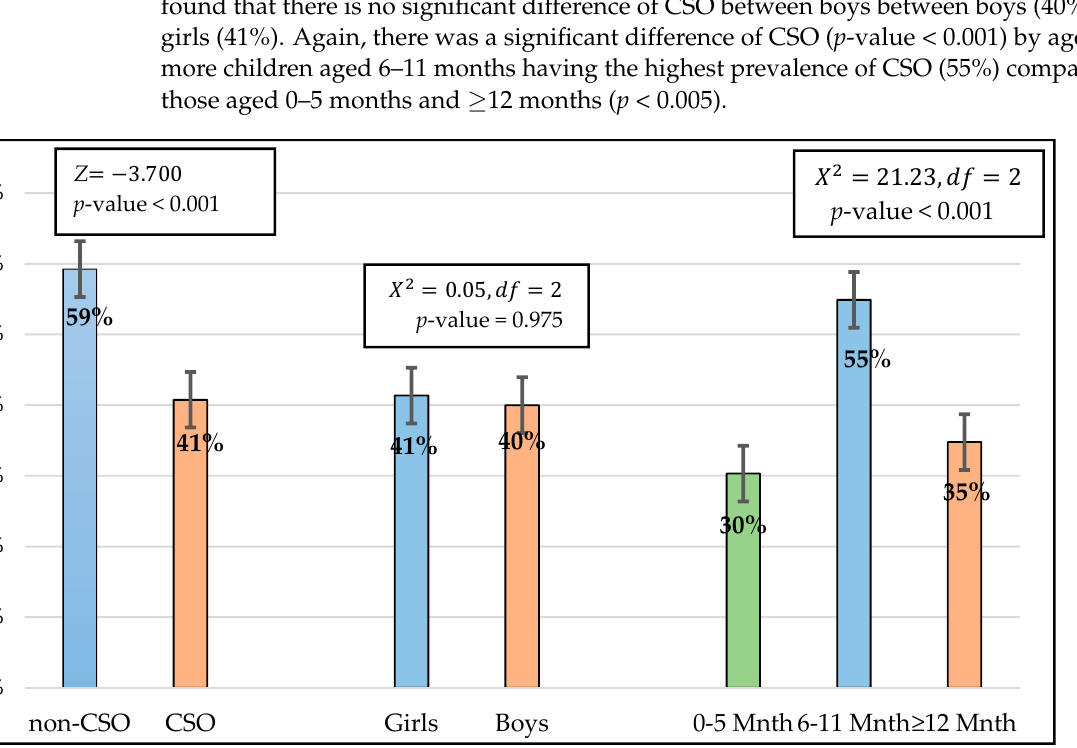
Figure 1. Prevalence of CSO for all children, by sex and age.